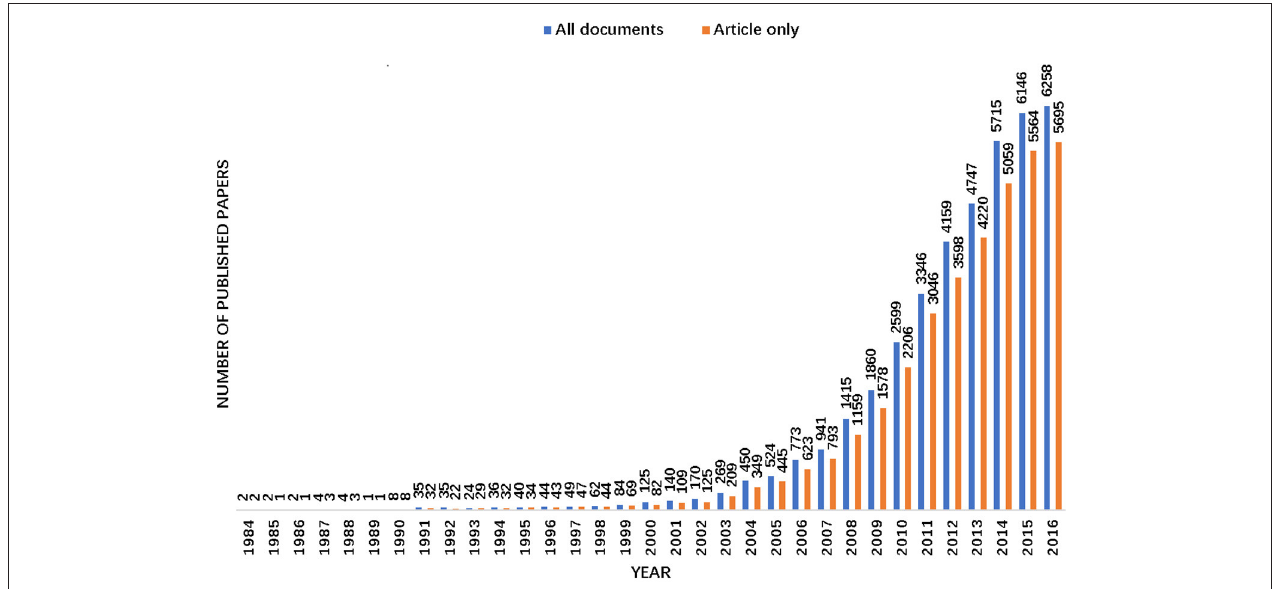
FIGURE 1 | Time sequence of relevant published papers of all documents and articles on organic solar cells in WoS.